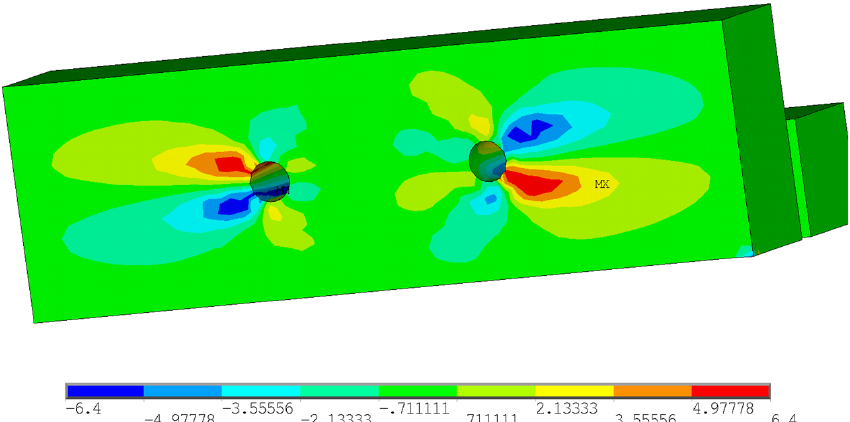
Figure 18. Shear stress in the XY plane (longitudinal shear).